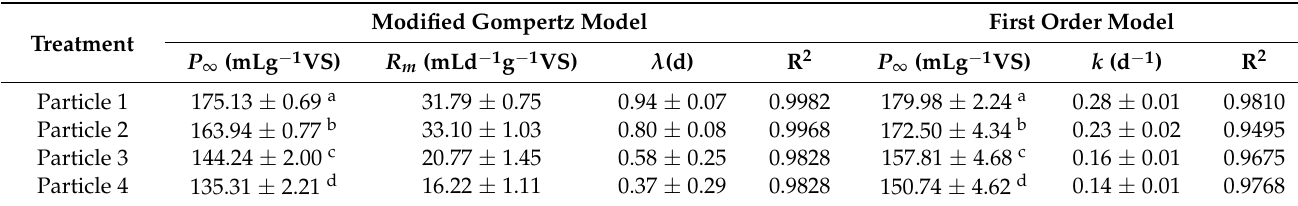
Table 3. Kinetic parameter of methane production in different particle size groups.